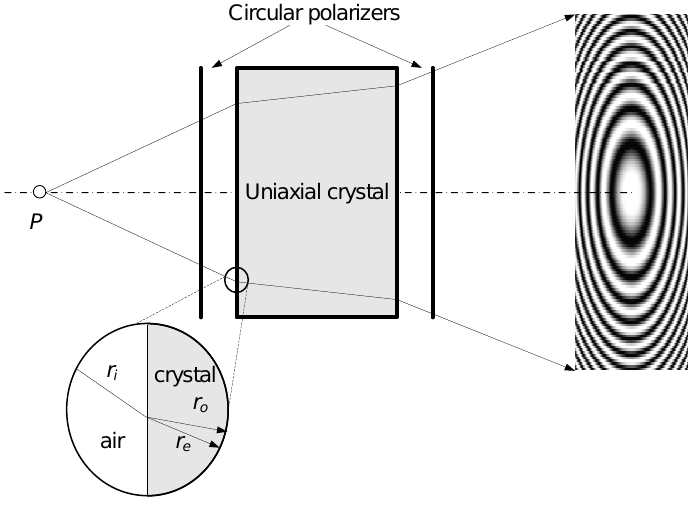
Figure 3. Conoscopic Holography working principle (courtesy of